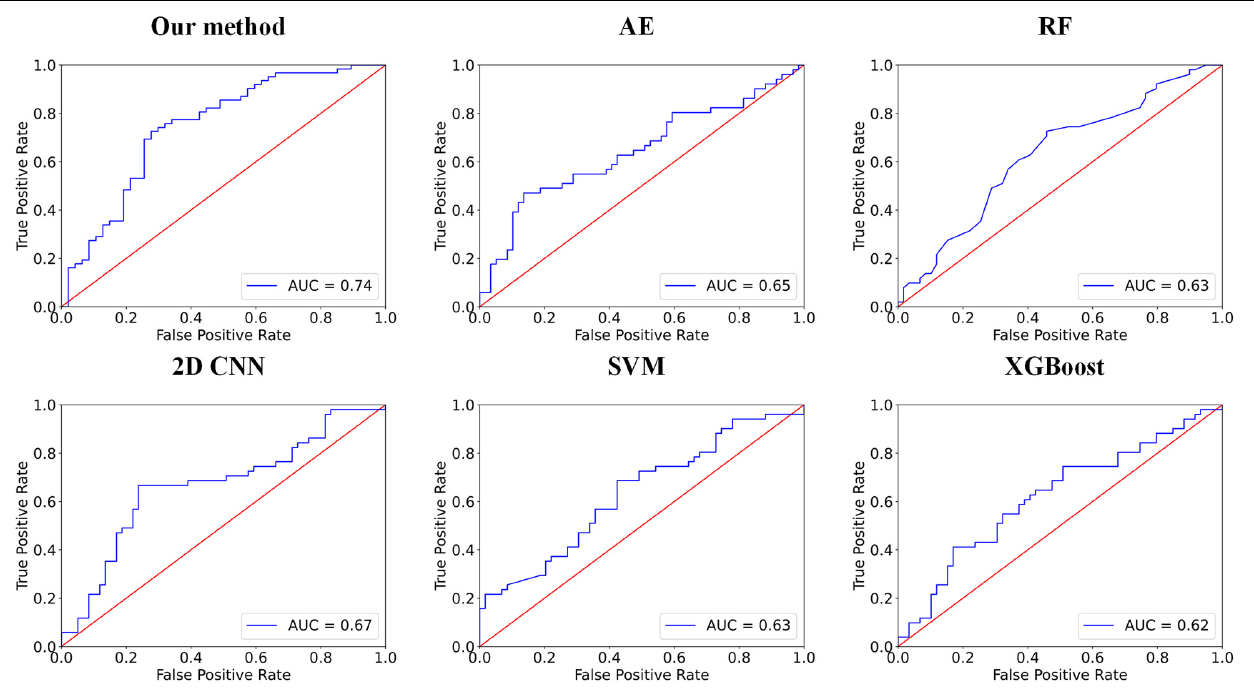
FIGURE 2 | Comparisons between our method and other methods for classification. The area under the curve (AUC) values are used to assess the classification performances for our method, 2D CNN, autoencoder (AE), RF, support vector machine (SVM), and Xgboost (XGB).